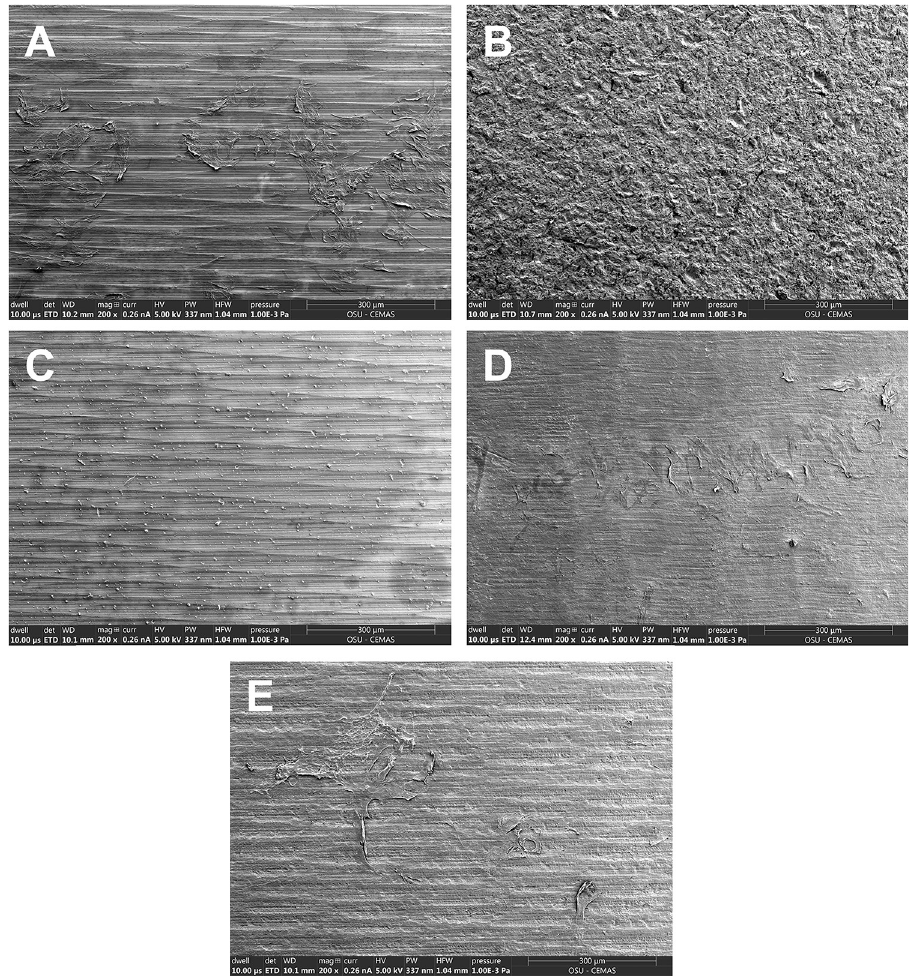
Fig 6. Residual tissue attachment to abutment materials after removal from human engineered gingiva. Scanning electron micrographs of abutment posts following implantation into human engineered gingiva for 7 days. A) Machined CP Ti, B) SLA surface modification, C) TiN, D) Zirconia and E) PEEK implants. Residual cellular attachment to the abutment surface following abutment retrieval was observed in the machined CP Ti, zirconia and PEEK groups. Scale bar = 300 μ